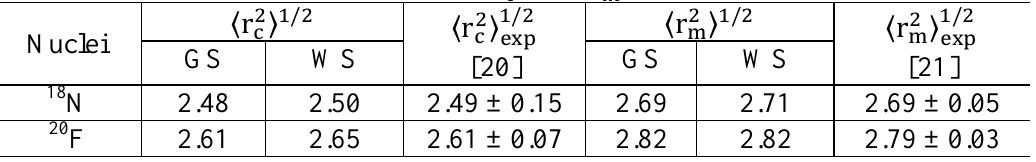
Table 3: The calculated for 18 N and 20